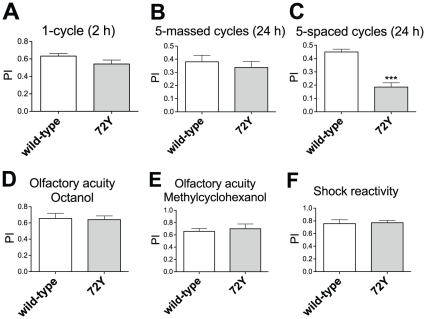
Behavioral analysis of the 72Y enhancer-trap mutant.(A) STM analysis. Performance indices (PI) were measured 2 hrs after a single conditioning cycle (t test, p = 0.0913, n≥10). (B) ARM analysis. PI were measured 24 hrs after five massed conditioning cycles (t test, p = 0.5298, n≥12). (C) LTM analysis. PI were measured 24 hrs after five spaced conditioning cycles (t test, p<0.0001, n≥17). Olfactory acuity for (D) octanol (t test, p = 0.8645, n = 16) and (E) methylcyclohexanol (t test, p = 0.6309, n≥12). (F) Shock sensitivity (t test, p = 0.8550, n = 10). Bars indicate mean ± SEM.